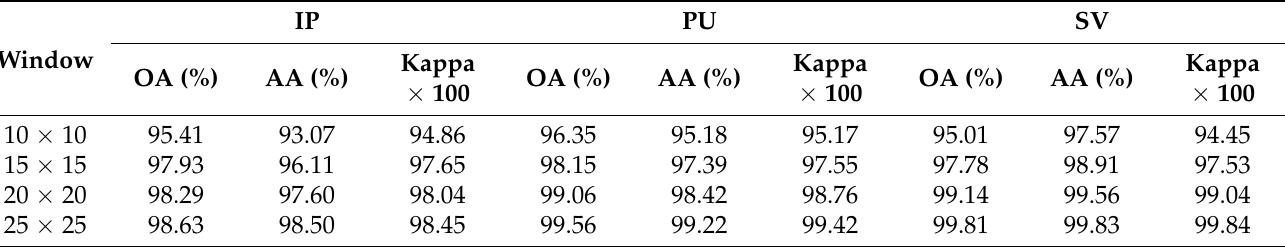
Table 4. Impact of the input window size of the 3-D patches on the performance.